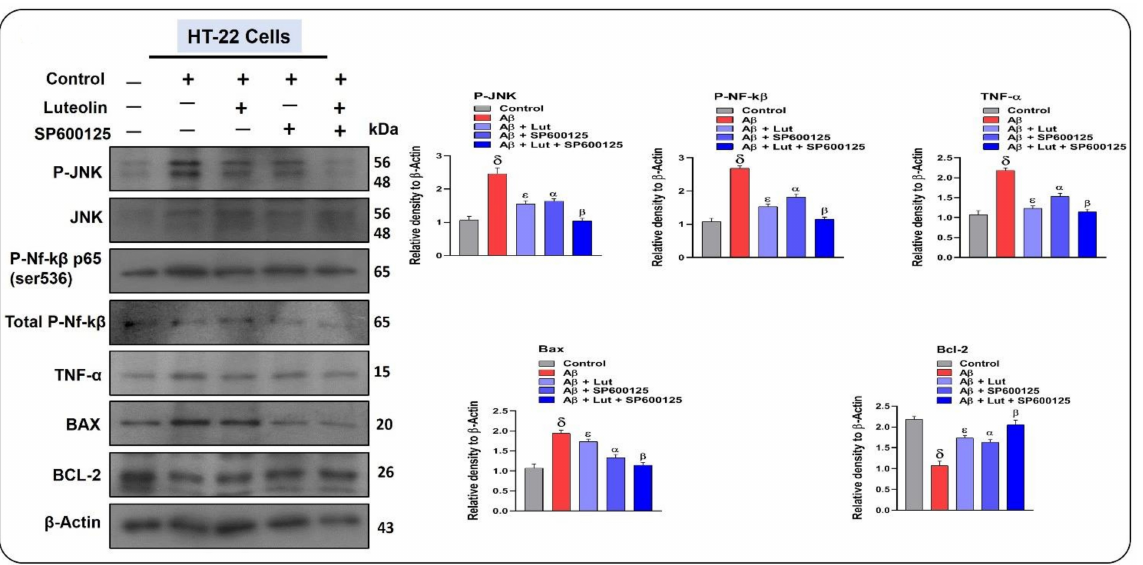
Figure 6. Luteolin conferred neuroprotection in a JNK-dependent manner. Western blot results of p-JNK, p-NF-kB, TNF α , Bax, and Bcl-2 in HT22 cells; β -actin was used as a loading control. For the statistical analysis, Graph Pad Prism 5 software was used, and one-way ANOVA and posthoc multiple comparison tests were employed. Significance = 0.05, δ = Significant difference between A β -treated cells and the control group, ε = significance difference between A β and A β + Luteolin groups, α = significance difference between A β and A β + SP600125, β = significance difference between A β and A β + Luteolin +